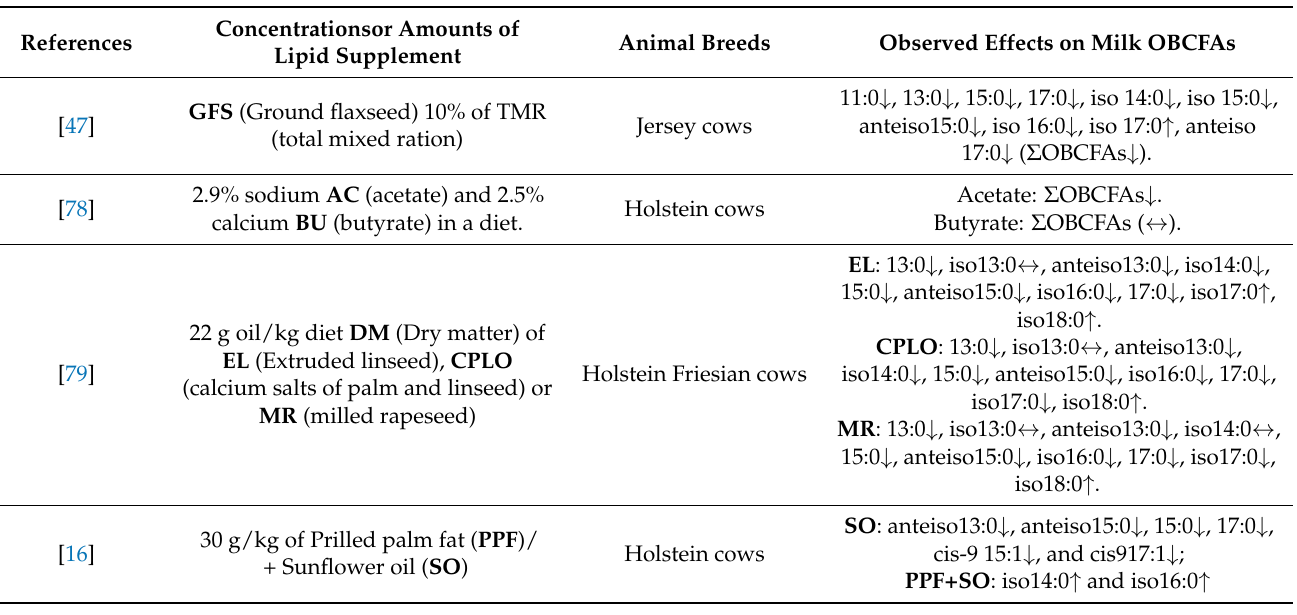
Table 2. Summary of the effects of lipid supplements on milk OBCFAs in dairy